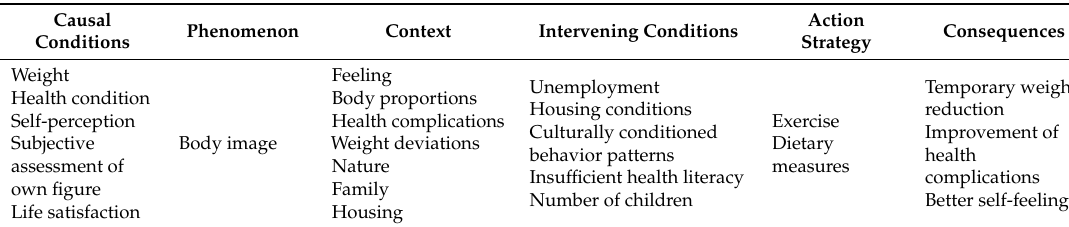
Table 3. Application of paradigmatic